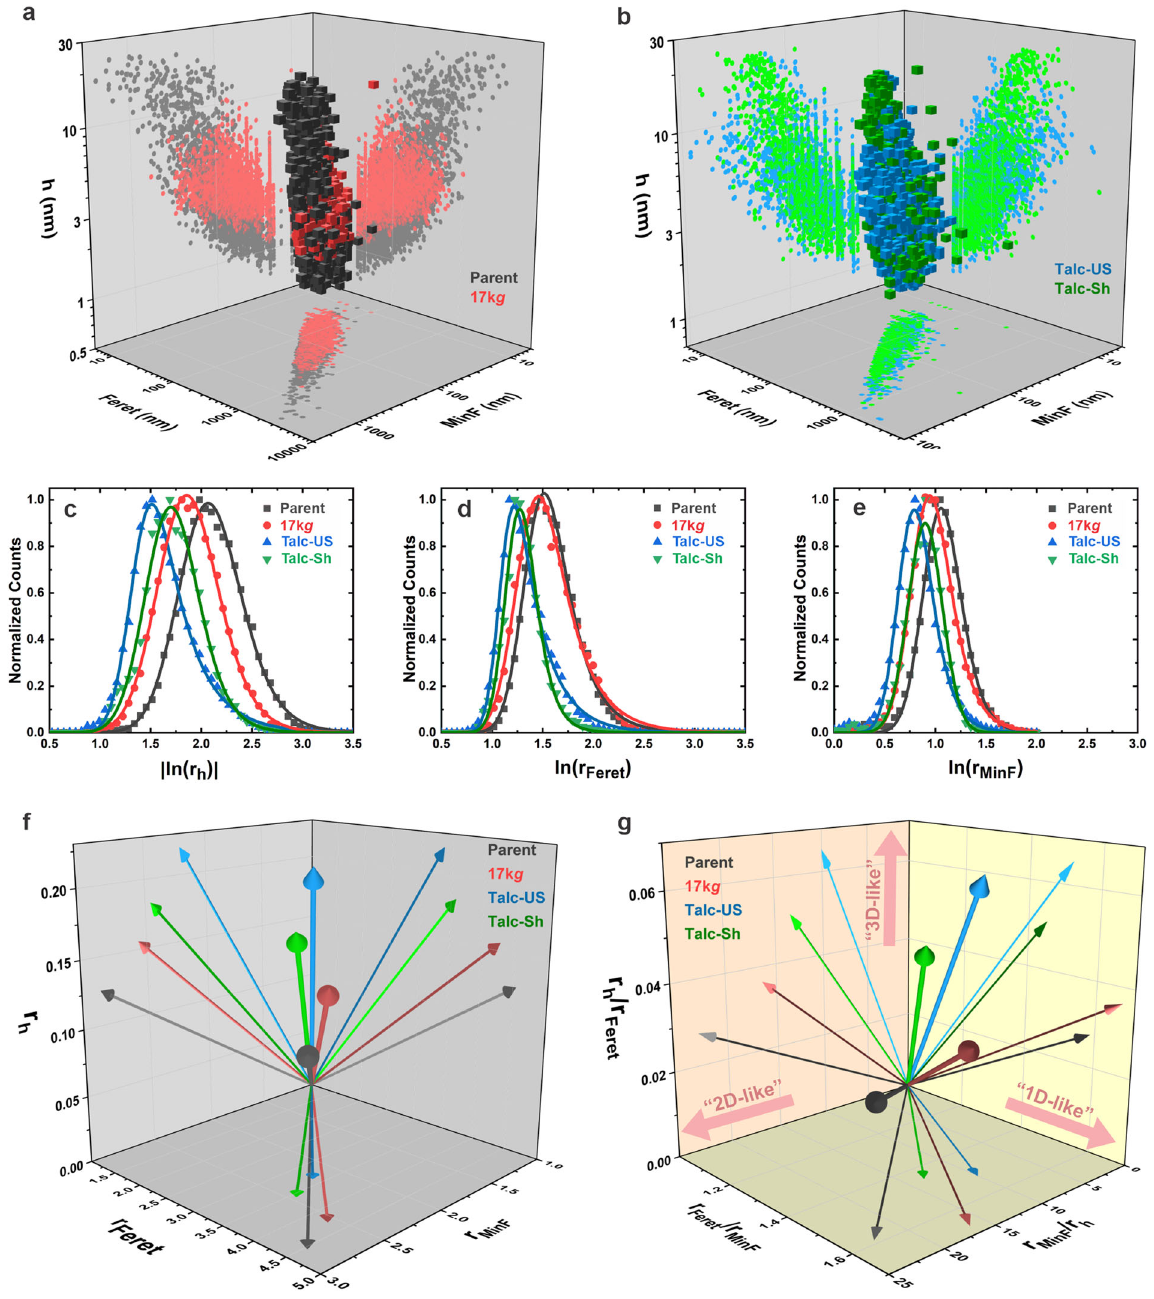
Fig. 2 Characteristic lengths, normalized probability distributions, and topological vectors of dimensionless aspect ratios r h , r Feret , and r MinF for graphene and talc fl akes. a, b 3D plots of characteristic lengths (average height, maximum, and minimum calipers) for more than 10,000 fl akes each of two graphene systems and two talc systems, respectively. The projections along each plane are also shown. c – e Normalized distributions of ln(r h ), ln(r Feret ) and ln(r MinF ), respectively, for each system (Parent — black squares; 17 k g — red circles; Talc-US — blue up triangles; Talc-Sh — green down triangles). For the r h case, the absolute value of the logarithm was plotted to enable a direct comparison with the other two distributions. f Three-dimensional topological vector representation of r h , r Feret , and r MinF for all four systems, with projections along each plane. g Topological vectors and their respective plane projections of three pairwise ratio combinations of r h , r Feret , and r MinF